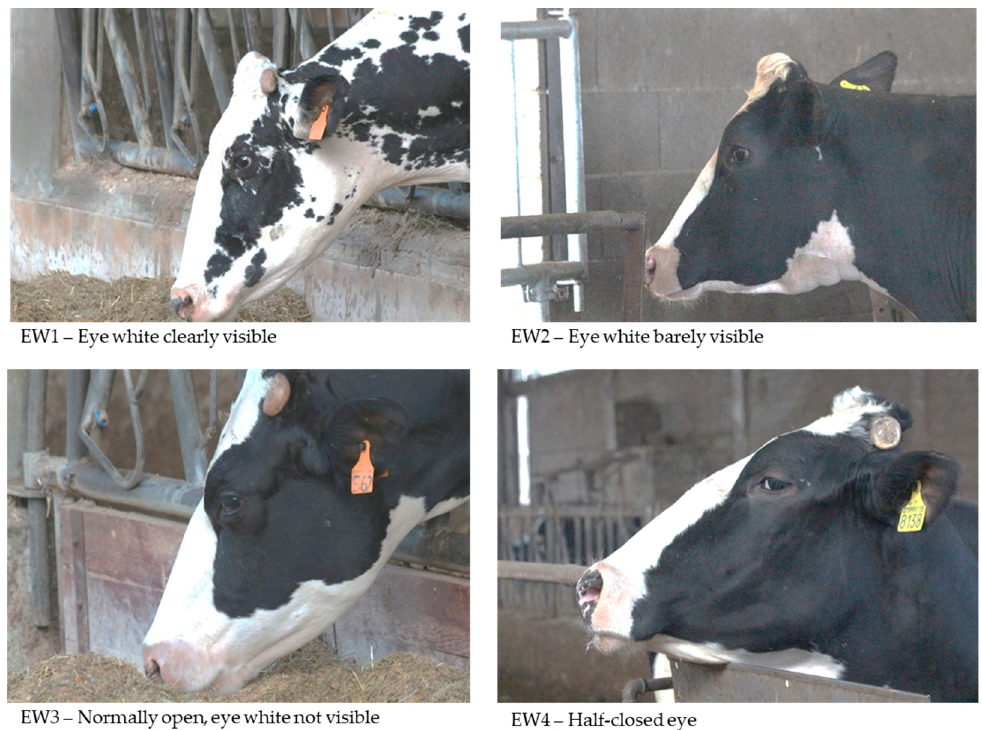
Figure 1. Eye white classification.